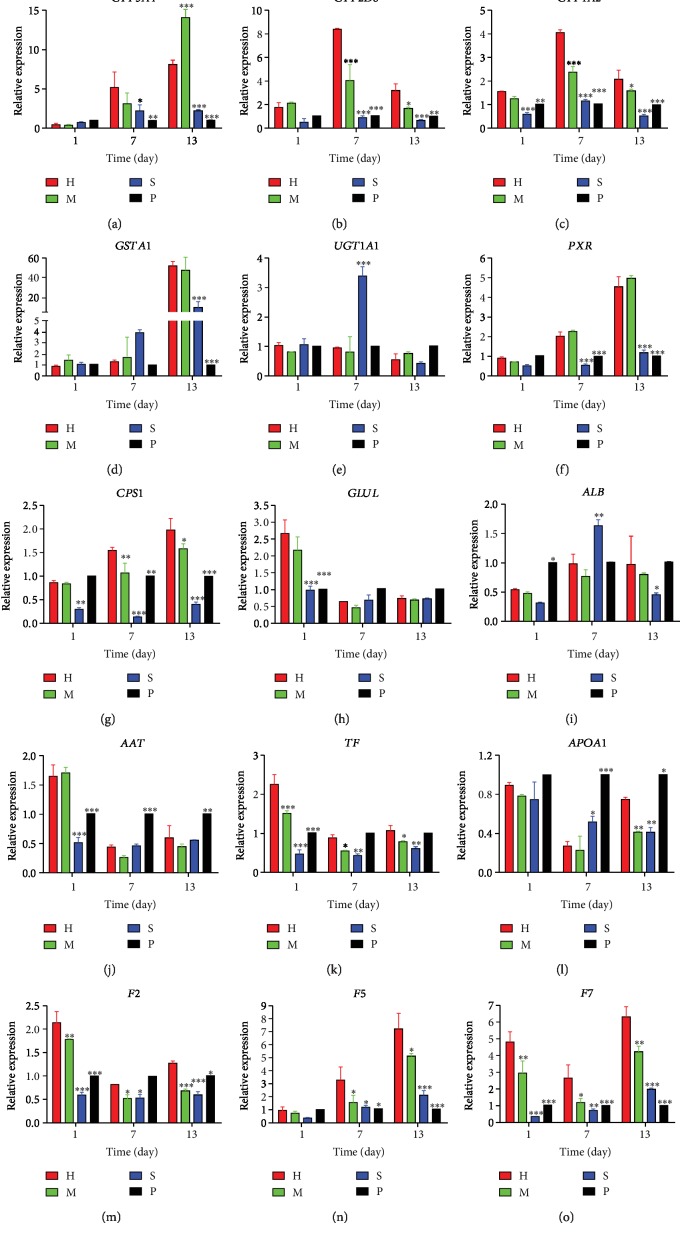
Quantification of hepatocyte functional gene expression levels: comparison of gene expression associated with liver detoxification and metabolism (a–f), ammonia metabolism and clearance (g, h), protein metabolism (i–l), and coagulation function (m–o). The data are presented as mean ± SD. Two-way ANOVA: comparison between H and other groups: ∗P < 0.05, ∗∗P < 0.01, ∗∗∗P < 0.001. H: hepatic plate-mimetic group; M: mixed 3D group; S: sandwich group; P: mixed 2D/plate group.